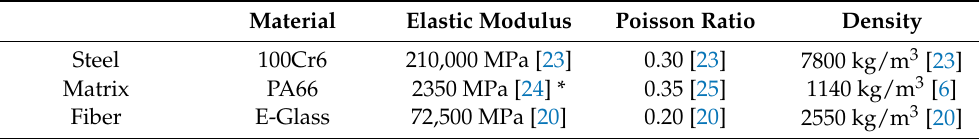
Table 1. Considered mechanical properties of steel ball and matrix and fiber phases FRP. Material Elastic Modulus Poisson Ratio Density Steel 100Cr6 210,000 MPa [23] 0.30 [23] 7800 kg/m 3 [23] Matrix PA66 2350 MPa [24] * 0.35 [25] 1140 kg/m 3 [6] Fiber E-Glass 72,500 MPa [20] 0.20 [20] 2550 kg/m 3 [20]